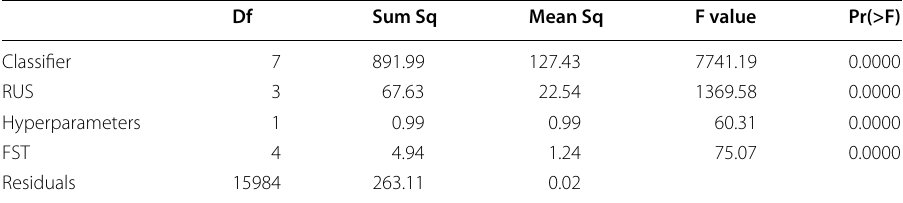
Table 23 ANOVA for classifier, RUS, hyperparameters and FST as factors of performance in terms of AUPRC Df Sum Sq Mean Sq Classifier